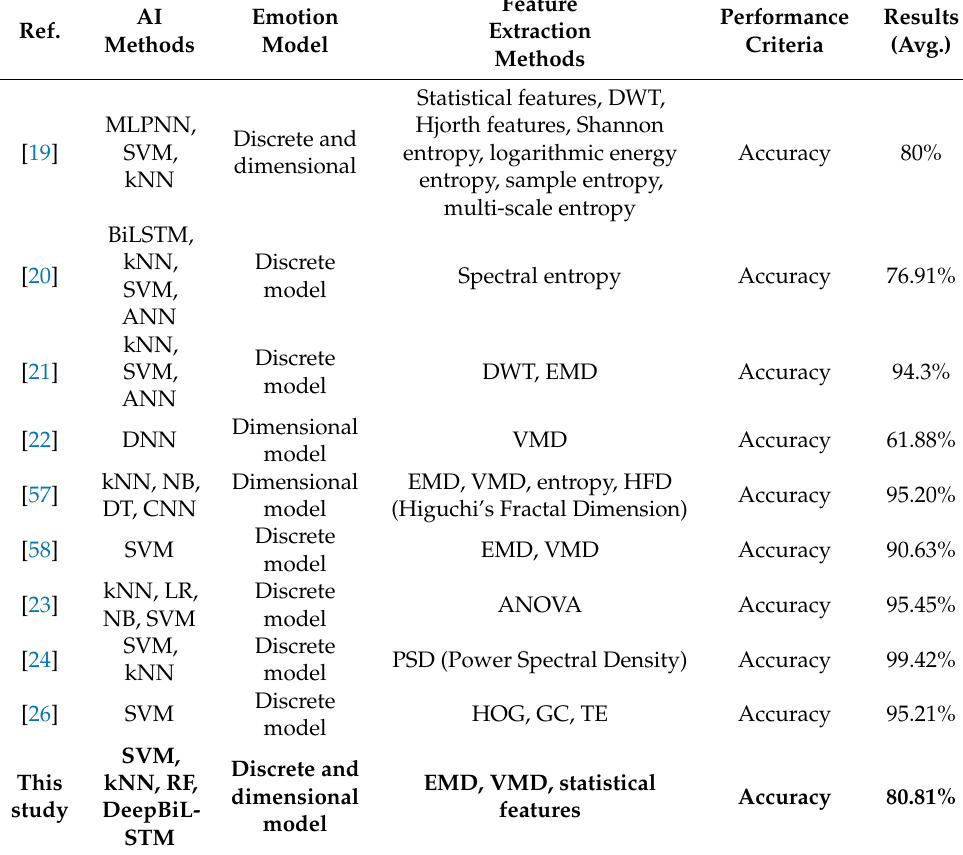
Table 4. A comparison table with previous studies.